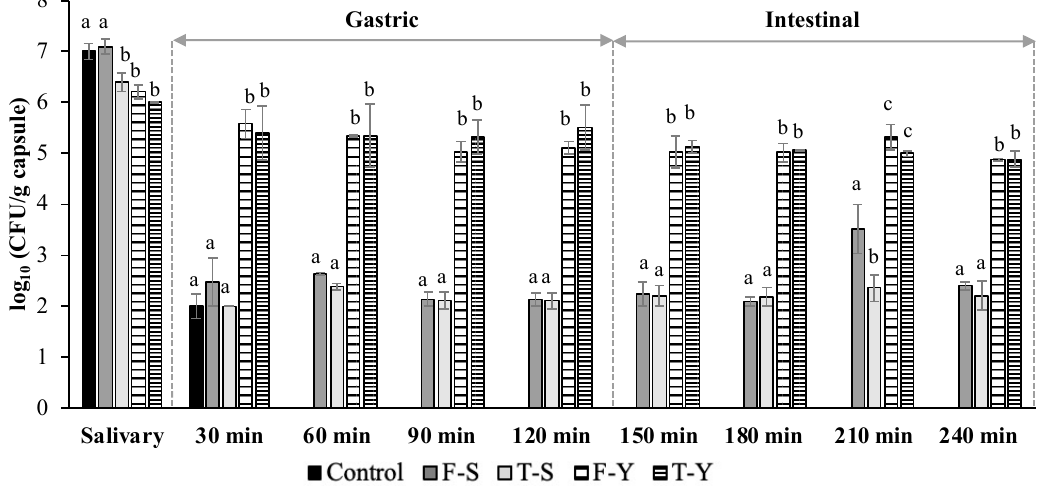
Figure 4. Variation of the concentration of L. paracasei (log 10 CFU/g of capsule and log 10 CFU/mL in the case of control sample) throughout the in vitro digestion test. F-S refers to freeze-dried capsules rehydrated in saline solution, T-S to thermal-dried capsules rehydrated in saline solution, F-Y to freeze-dried capsules rehydrated in yogurt, and T-Y to thermal-dried capsules rehydrated in yogurt. Experiments were carried out in triplicate and reported results correspond to the mean value. Different letters indicate significant differences ( p < 0.05).